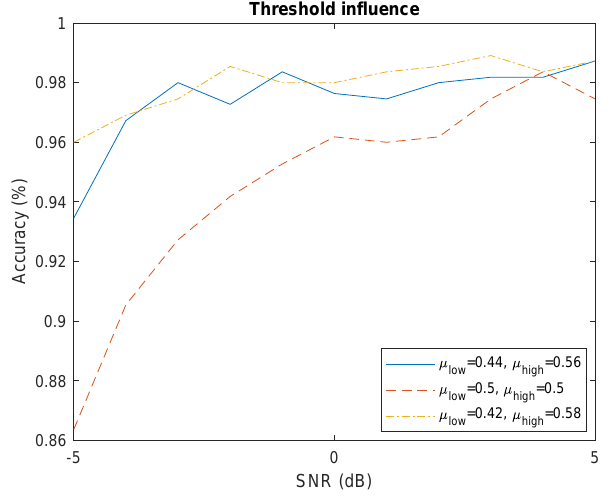
Figure 10. Influence of threshold values on